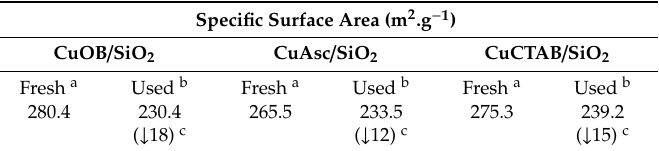
Table 2. Specific surface area data of fresh and used